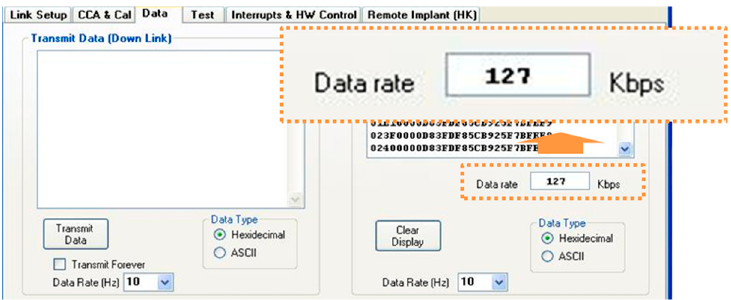
Figure 14. Data rate test result.